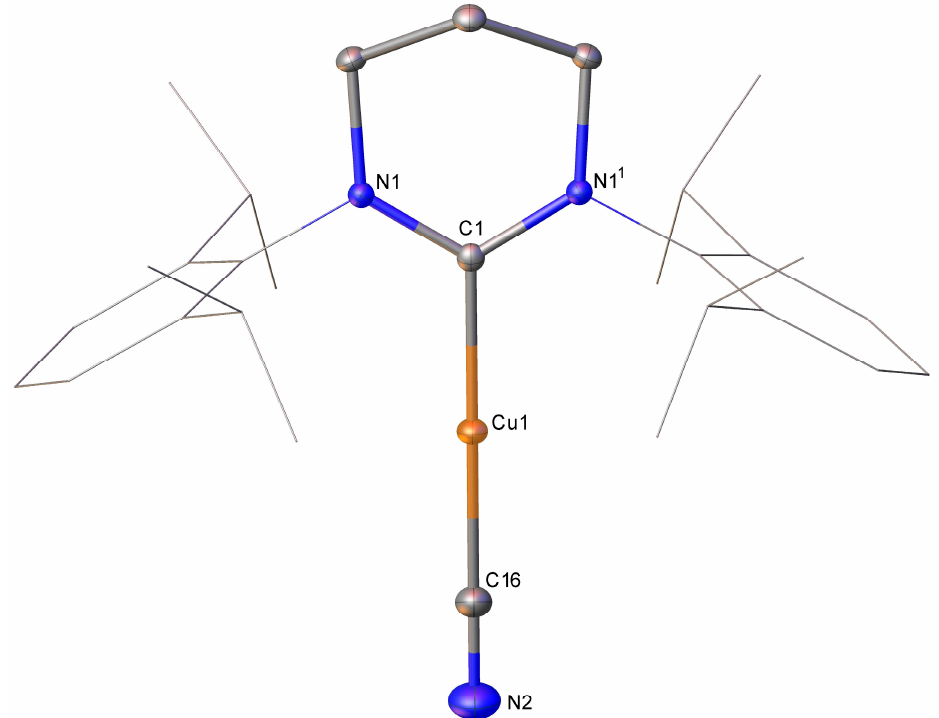
Figure 2. Molecular structure (30% probability ellipsoids) of 2 . Hydrogens have been omitted for clarity. Wireframe view has been employed for Dipp groups, also for visual simplicity. Selected bond lengths (Å), angles ( ◦ ): N1-C1 1.3402(13); C1-Cu1 1.9187(17); Cu1-C16 1.905(2); C16-N2 1.110(3); N1-C1-N1 1 117.55(15); N1-C1-Cu1 121.20(8); C1-Cu1-C16 177.49(9); Cu1-C16-N2 179.9(2). Symmetry − y , z operations (1); x , 1 2